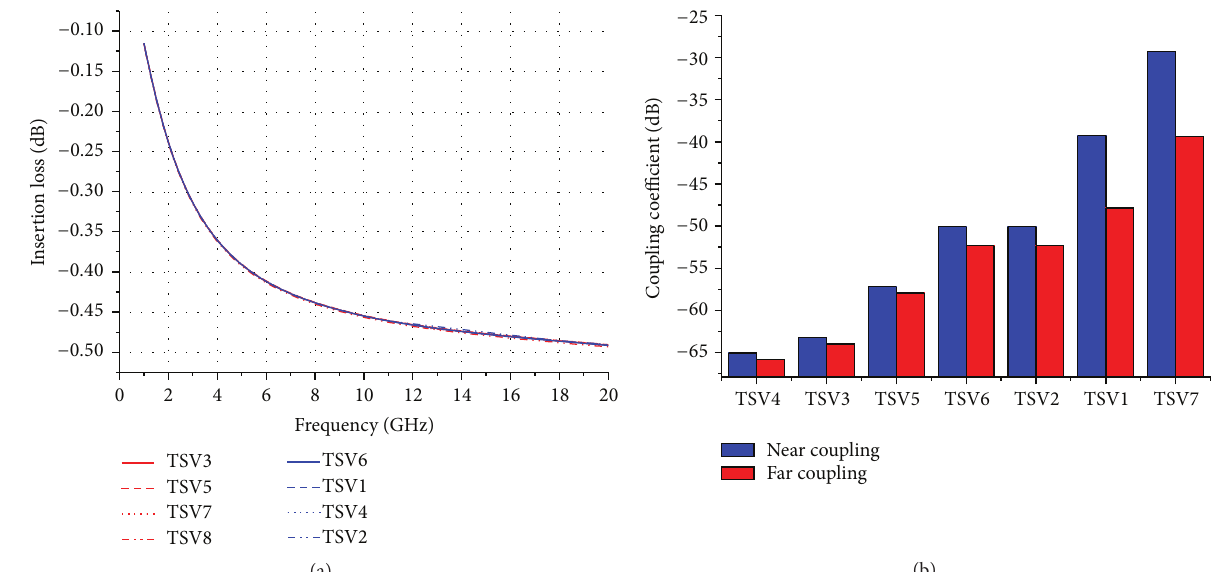
Figure 16: 𝑆 parameters result of Model 3. (a) Insertion loss of each TSV and (b) the cross talk from the aggressive TSV to TSV8 at